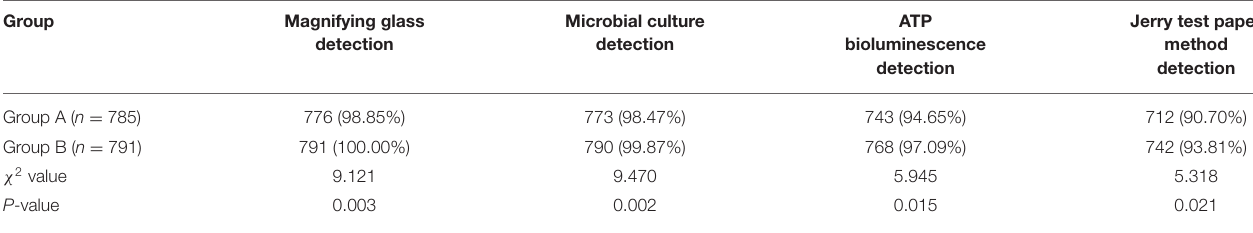
TABLE 4 | Comparison of qualified rate of disinfection between two groups ( n ,